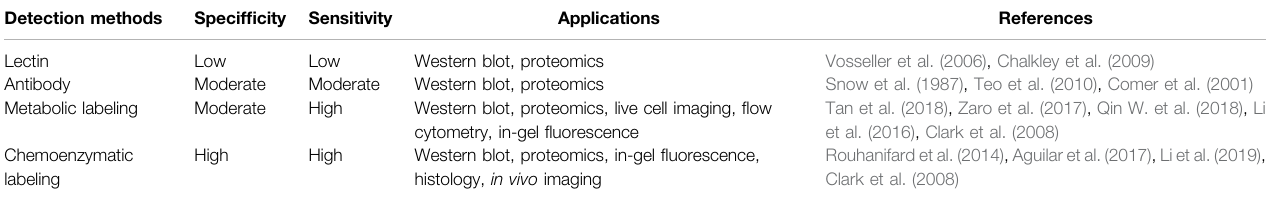
TABLE 1 | The comparison of different detection methods for O-GlcNAcylation. Detection